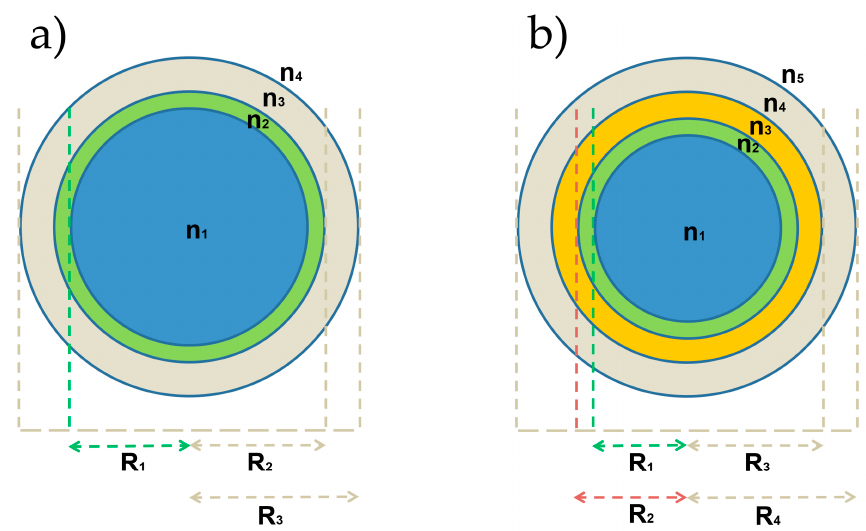
Figure 2. Cross sections of an OMBR-based biosensor: ( a ) 4-layer structure, where there is only a biological layer on the OMBR inner surface; and ( b ) 5-layer structure, where between the biological layer and the OMBR inner surface there is a high refractive index polymeric layer (SU-8).